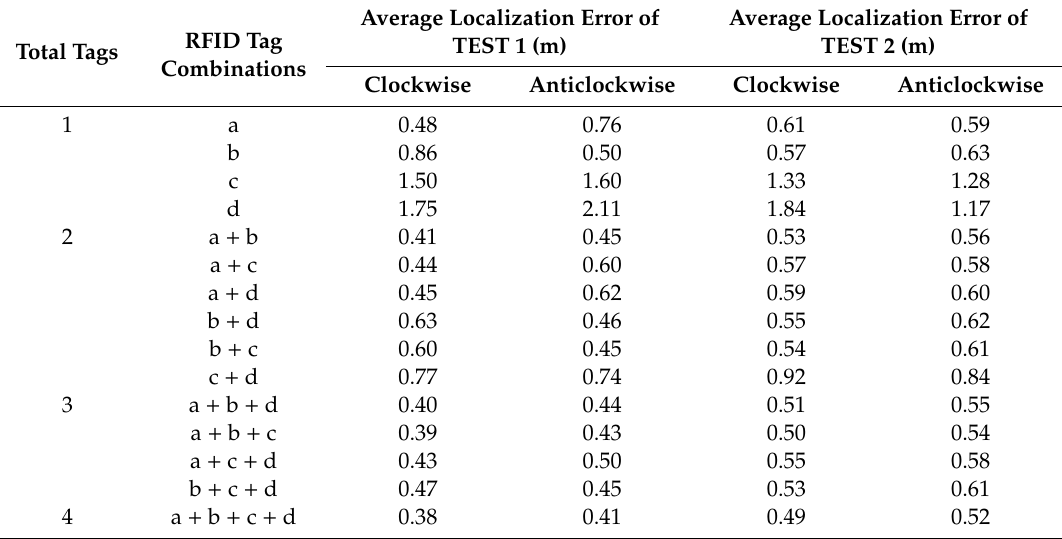
Table 3. Evaluation of the average localization error (meter).